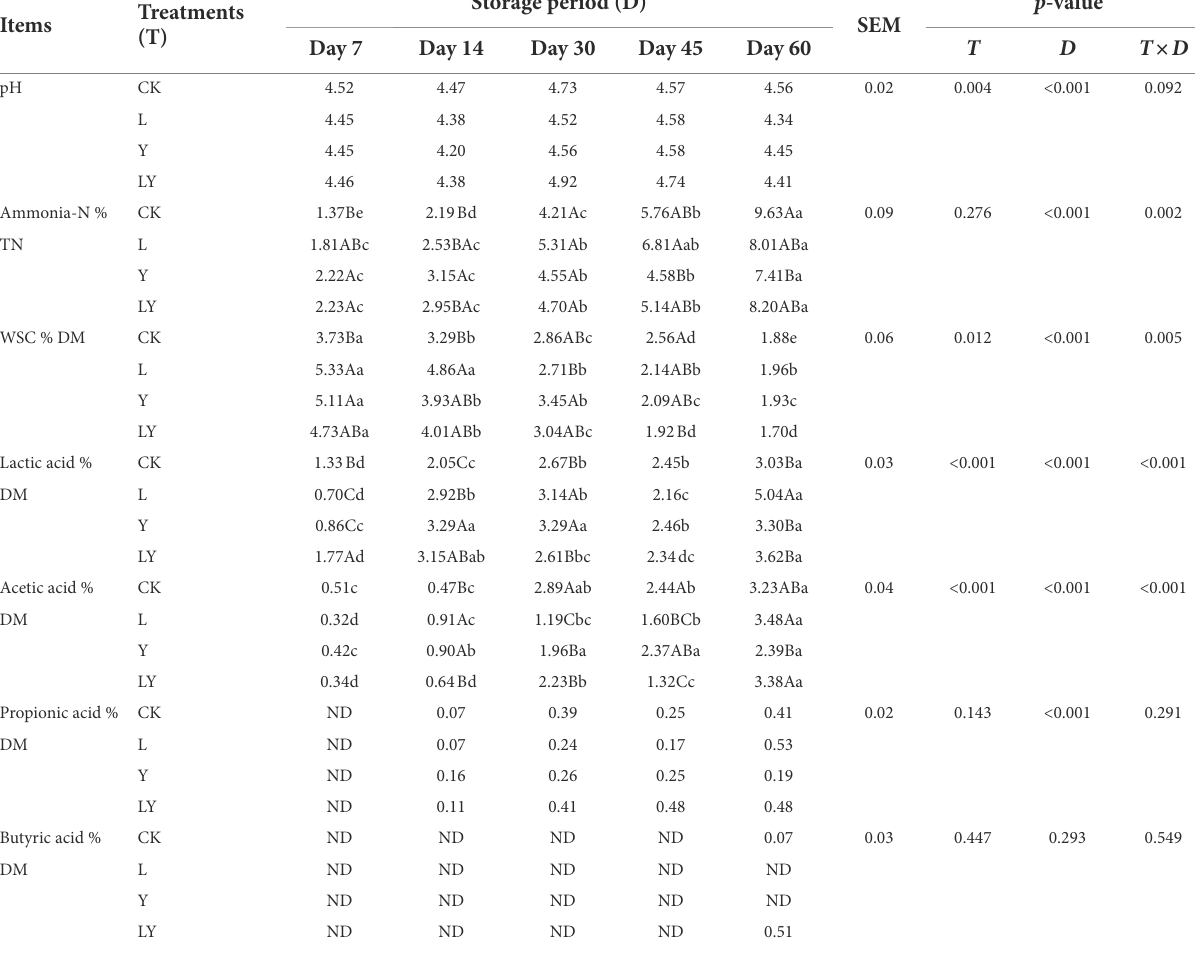
TABLE 3 Fermentation profile of cellulase-treated Pennisetum sinese (CTPS) during anaerobic storage. Treatments Items